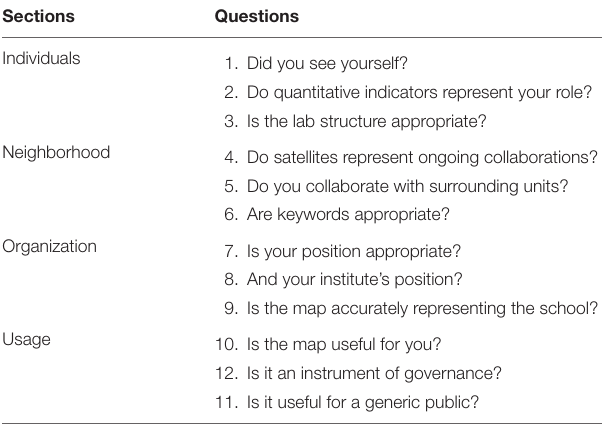
Table 2 | Questions schema used during interviews.